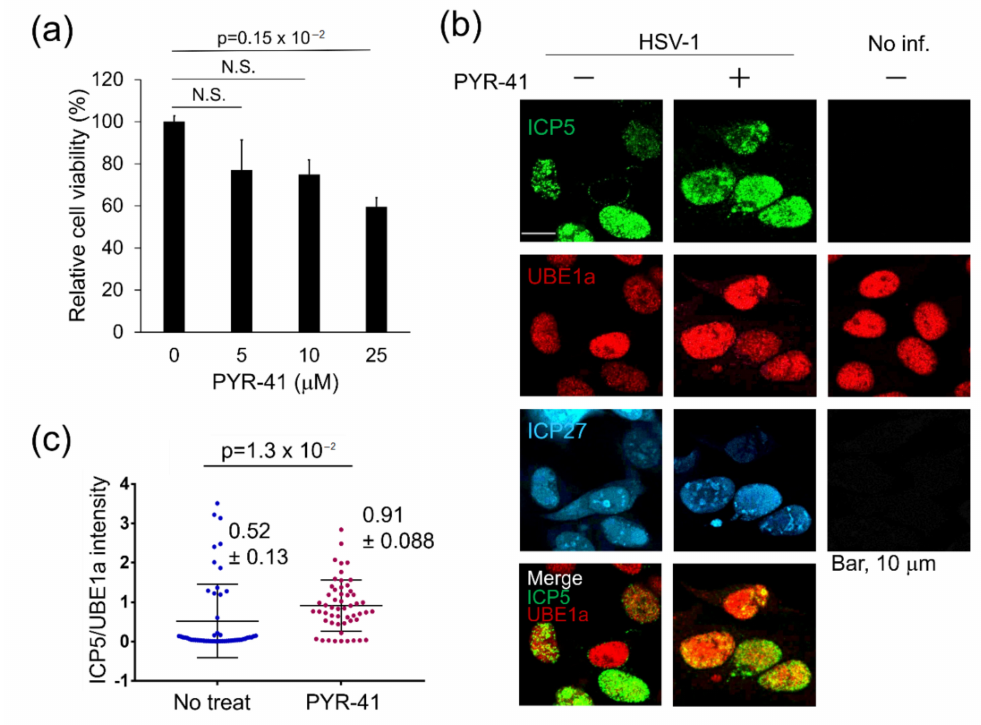
Figure 3. UBE1a inhibition by PYR-41 increased ICP5 expression in HSV-1 infected cells. ( a ) Cell viability of PYR-41 treated HeLa cells. HeLa cells were treated with 0–25 µ M PYR-41 and cultured for 48 h. The number of viable cells was evaluated by using a cell viability assay. The values obtained from PYR-41-untreated cells were set as 100%. N.S., not significant. ( b ) PYR-41 increased ICP5 expression in UBE1a highly expressing cells. HeLa cells infected with or without HSV-1 were cultured with 10 µ M PYR-41. At 18 hpi, cells were fixed and stained with anti-ICP5 (green), UBE1a (red), and ICP27 (cyan) antibodies. ( c ) The correlation of fluorescence intensity between UBE1a and ICP5 in infected cells in the absence or presence of PYR-41. The means ± standard deviations are shown ( n = 54 in each experiment). The y -axis is ICP5 intensity / UBE1a intensity measured by Image